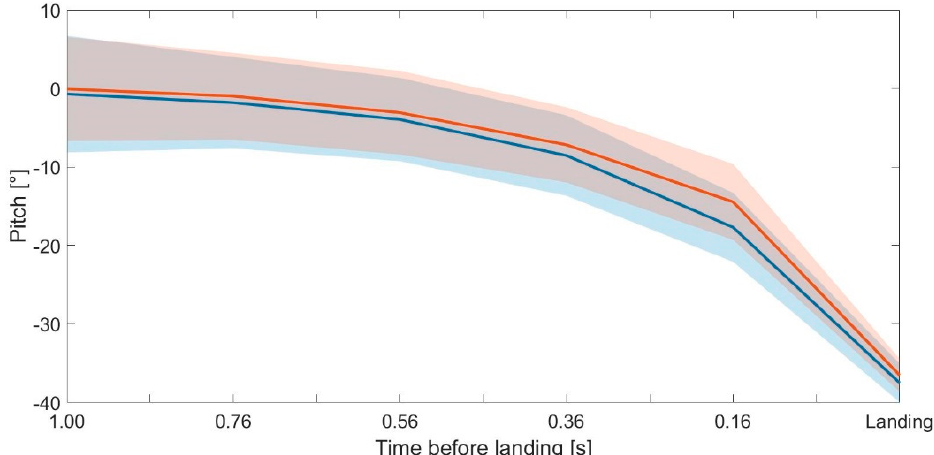
Figure 6. Average pitch movement and its SD from 1.00 before the landing impact until the landing for the left (in blue) and right (in red) ski at t 1.00 , t 0.76 , t 0.56 , t 0.36 , t 0.16 , and t 0.00 (landing impact) for the 30 collected jumps. A pitch angle of 0° corresponded to a horizontal/flat position of the ski in the air. Negative values corresponded to a movement of the ski tips in a clockwise direction (pointing down).